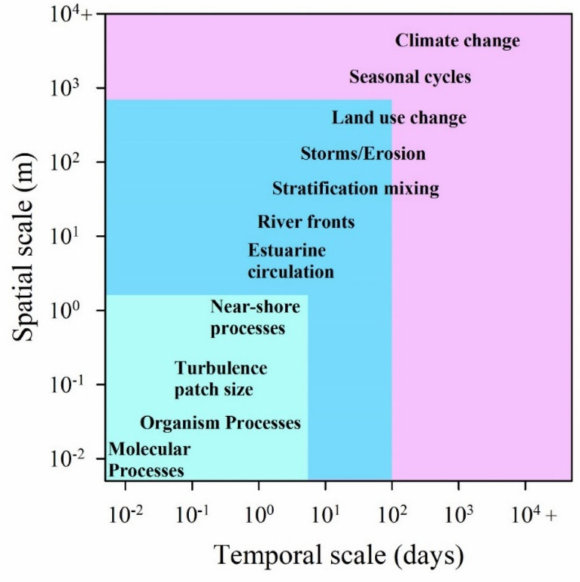
Figure 7. Continuum of temporal and spatial scale (resolution) and extent from molecular processes to large-scale hydrology and global climate